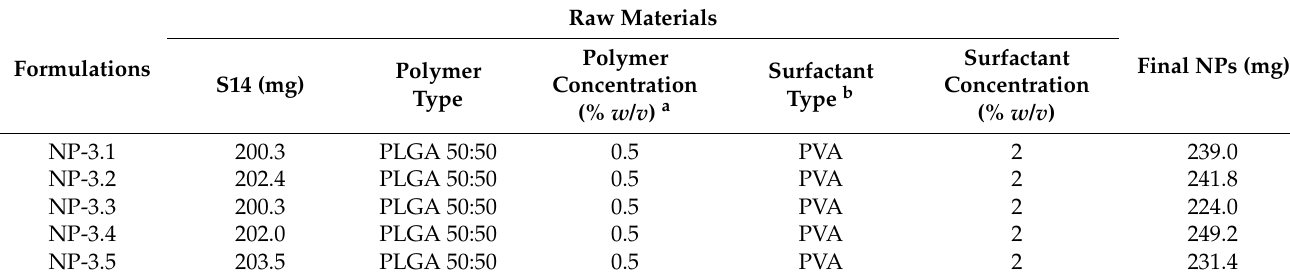
Table 4. Escalation process of S14-loaded PLGA nanoparticles by nanoprecipitation method.